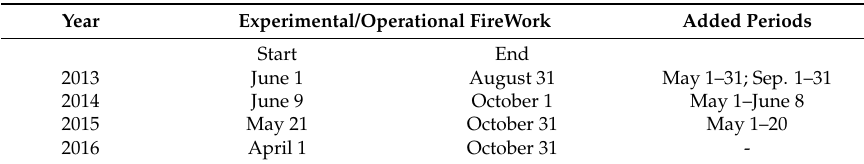
Table 1. 2013–2016 experimental and operational FireWork start/end forecast periods together with additional periods for which FireWork was rerun